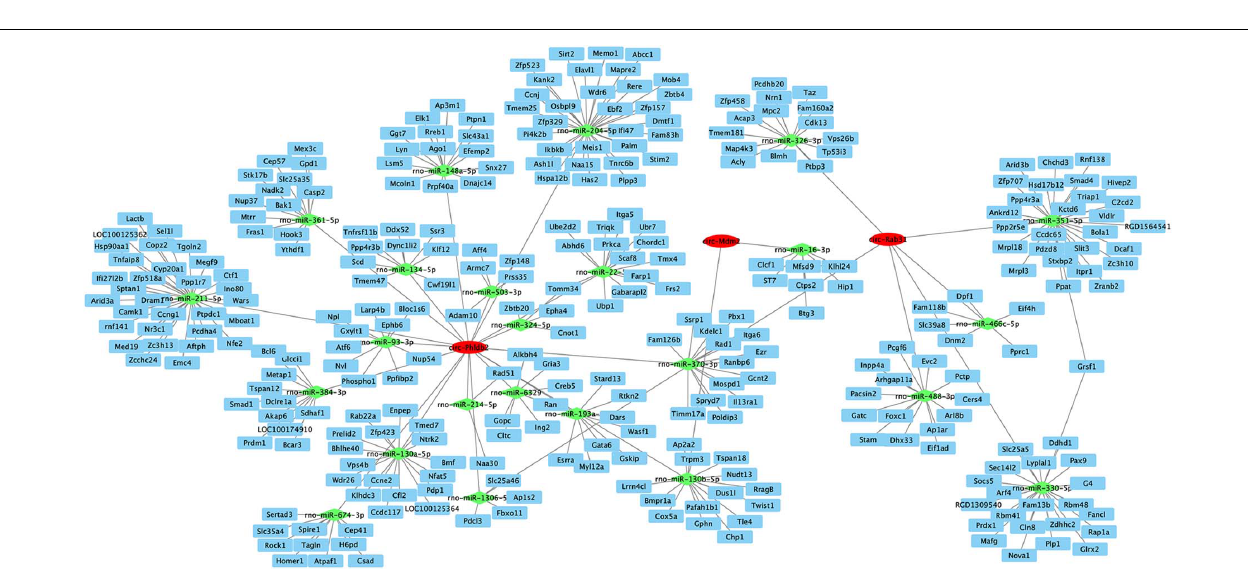
FIGURE 4 | Network of CircRNA–miRNA–mRNA interaction. Cytoscape was used to construct the network of two downregulated and one upregulated circRNA. Putative interactions between miRNAs and circRNAs were predicted using mirTarbase 7.0. We used mirdbV6 to predict the miRNAs’ target genes. Target scores > 90 were selected. In this figure, rectangles represent mRNAs, ovals represent circRNAs, and triangles represent